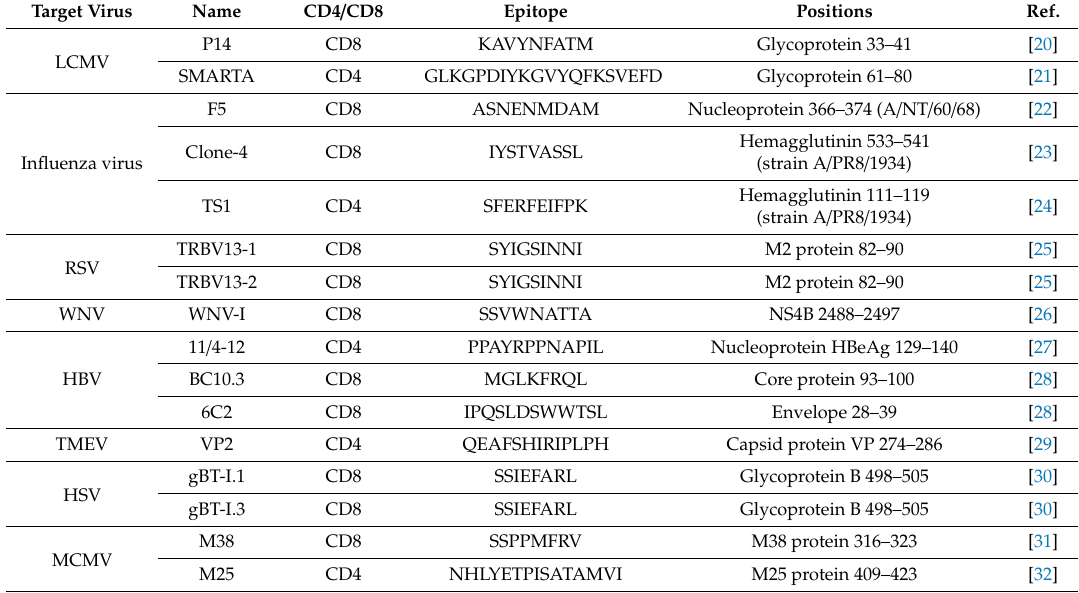
Table 1. TCR Transgenic mice used in the viral immunopathological